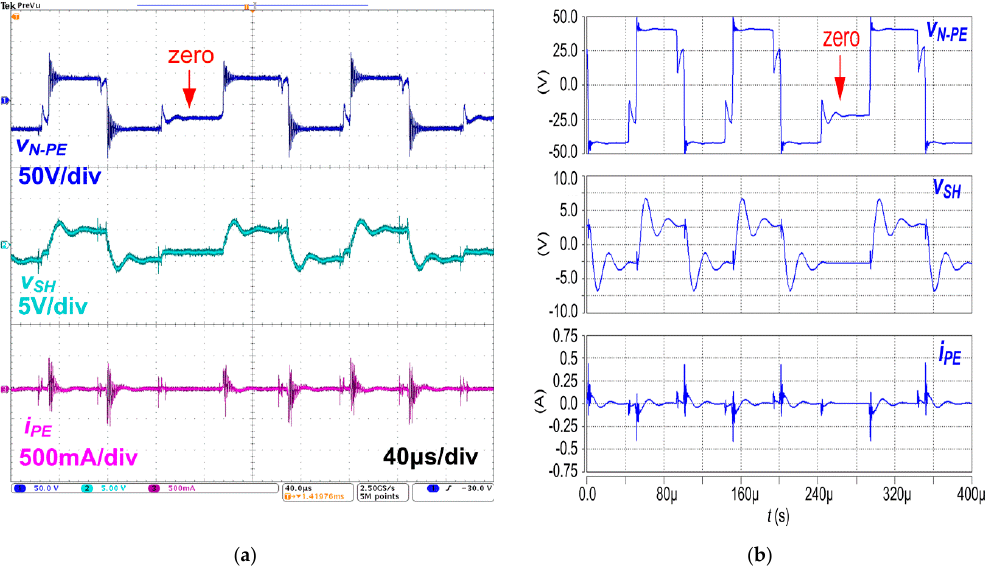
Figure 16. Waveforms of CM voltage u N-PE , shaft voltage u SH , and leakage ground current i PE ( a ) measurement; ( b ) simulation.